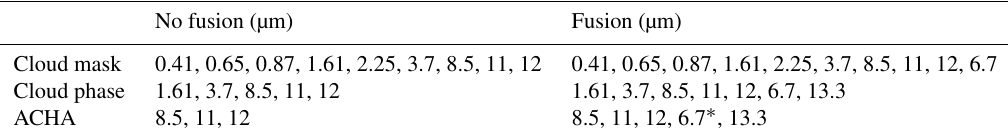
Table 1. Spectral channels used in the retrievals for fusion and no-fusion experiments. The asterisk indicates that we present ACHA results with and without the 6.7µm channel (results are without 6.7µm unless inclusion is